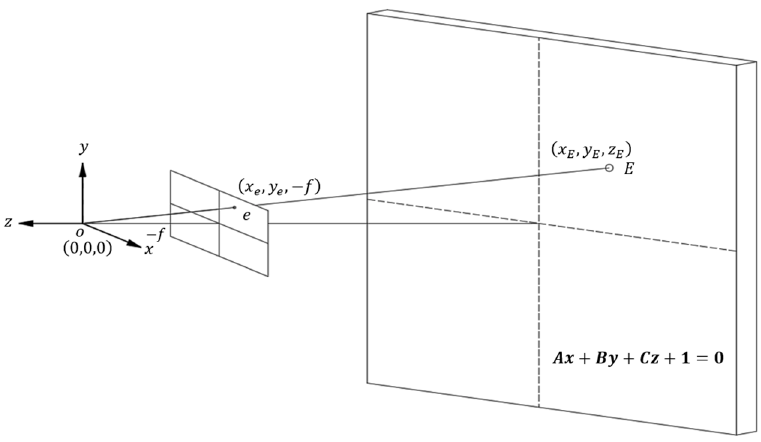
Figure 8. Calibrations for the control points, camera, and laser ranging modules. ( a ) Control points ( b ) Measurements made using the total station.